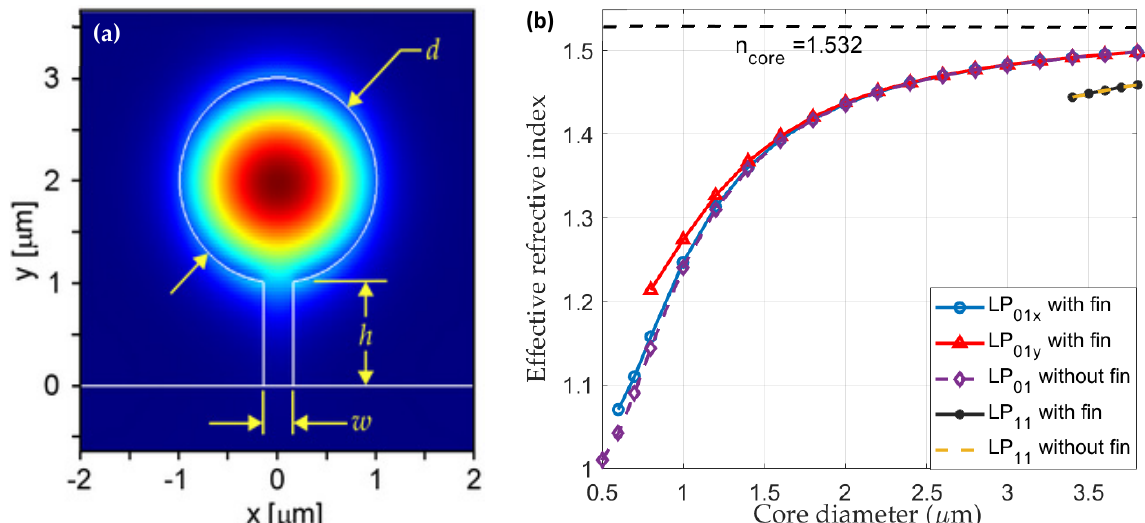
Figure 2. ( a ) Cross-section of the single mode waveguide supported by a nano-fin to the substrate, demonstrating the waveguide definitions of its diameter, d , fin height, h , and nano-fin width, w . ( b ) Variation of the guided modes’ effective indices at different core diameters for a free-standing waveguide, with and without the fin